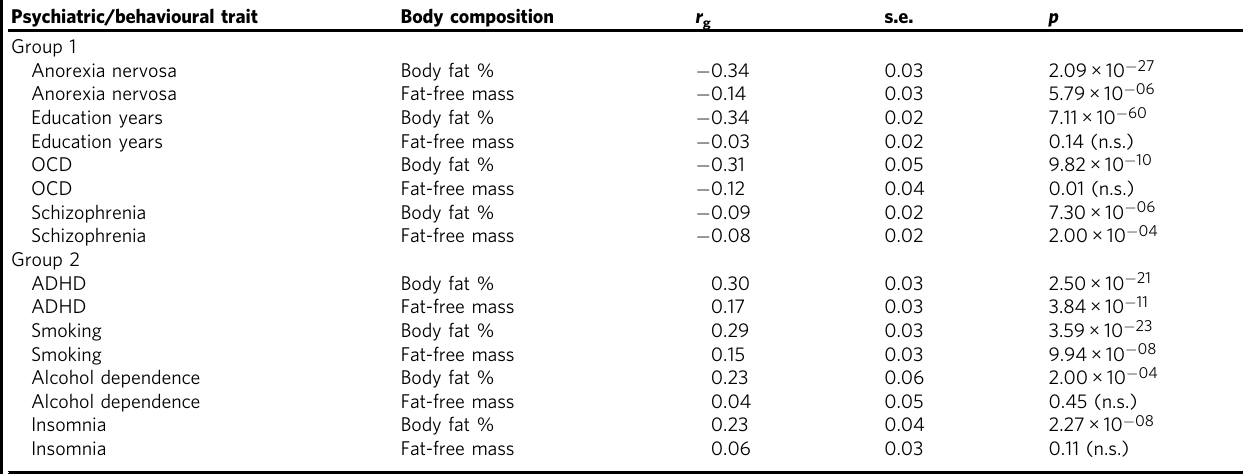
Table 1 Signi fi cant genetic correlations between psychiatric disorders, behavioural traits and body composition traits. Psychiatric/behavioural